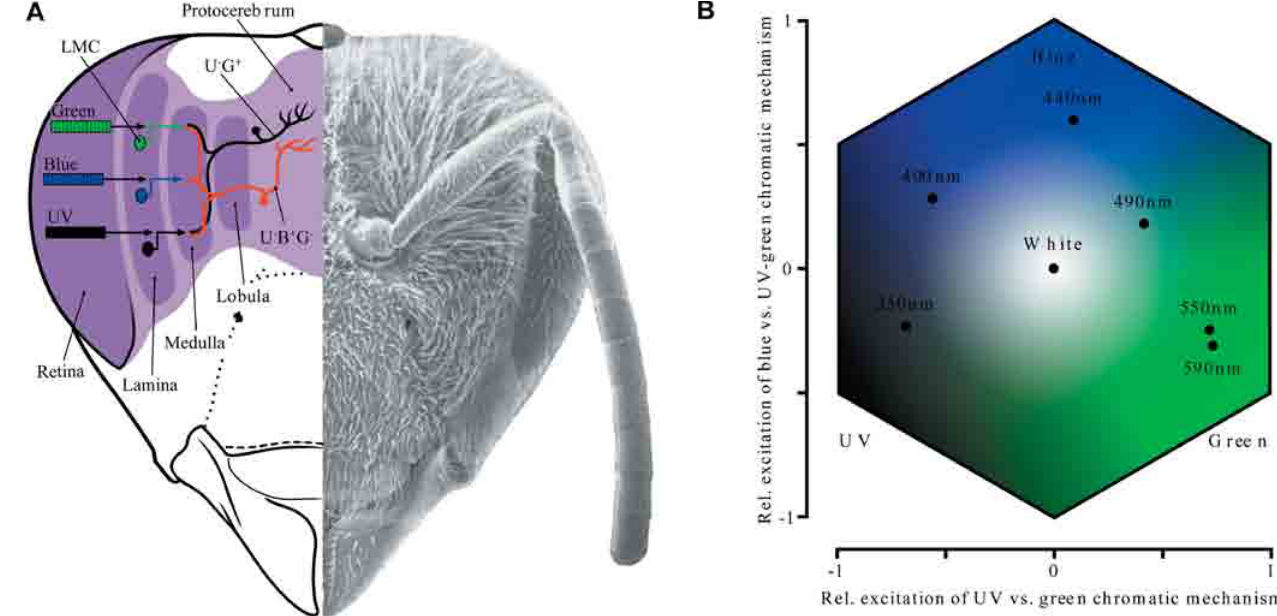
Figure 2. Neuronal Color Coding and Color Space in Bees (A) Frontal view of bee head (scanning electron micrograph) showing essential features of color processing in the brain. Information from the UV, blue, and green receptors is relayed from the fi rst optic ganglion, the lamina, to the second optic ganglion, the medulla, by so-called monopolar cells (LMCs); cell bodies are symbolized by fi lled circles. These cells feed into color opponent cells (drawn in red and black) found both in the medulla and lobula, either directly or via interneurons. Chromatic opponent cells receive antagonistic input from the different color channels, and project to the protocerebrum. (Image based on [5,18].) (B) Color opponent space for bees, where axes correspond to excitation values of two types of color opponent neurons. Corners correspond to maximum excitation of the UV (lower left), blue (top), and green (lower right) receptors. Color loci of some representative monochromatic lights are shown. Angular position in this space (as measured from the center) corresponds to hue, whereas distance between color loci corresponds to perceived